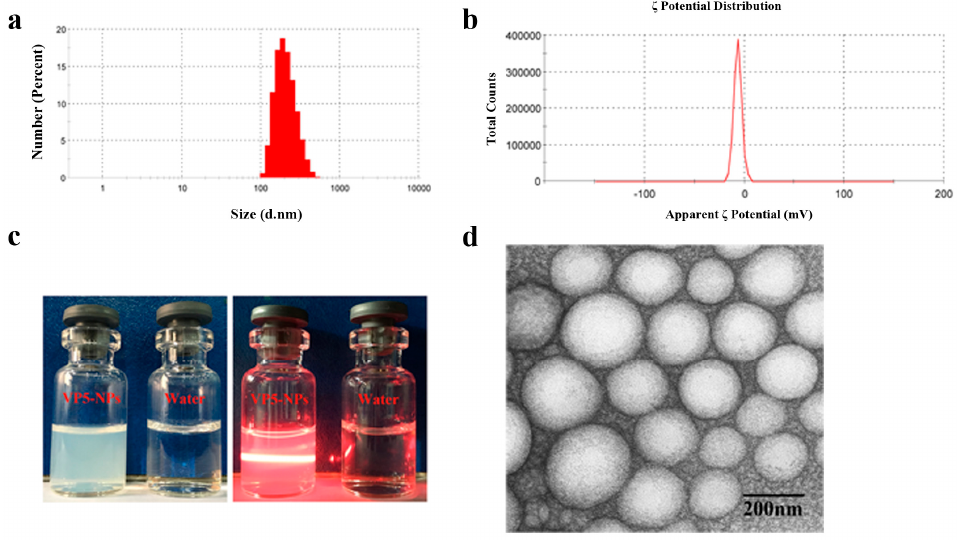
Figure 2. Pharmaceutical properties of VP5-NPs. ( a ) Size distribution; ( b ) ζ potential; ( c )